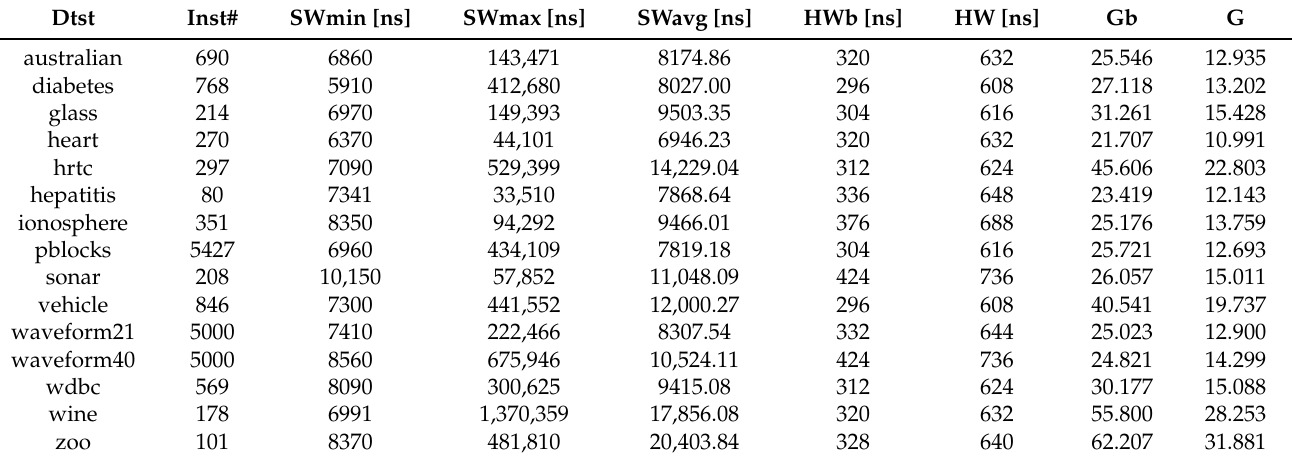
Table 13. Processing latency comparison between the software implementation of ANN classifier compared to